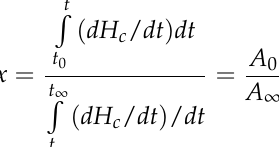
Figure 11. Boswell plots for ( a ) Ti 45 Zr 20 Be 35 , ( b ) Ti 45 Zr 20 Be 31 Co 4 , ( c ) Ti 45 Zr 16 Be 35 Co 4 , and ( d ) (Ti 45 Zr 20 Be 35 ) 96 Co 4